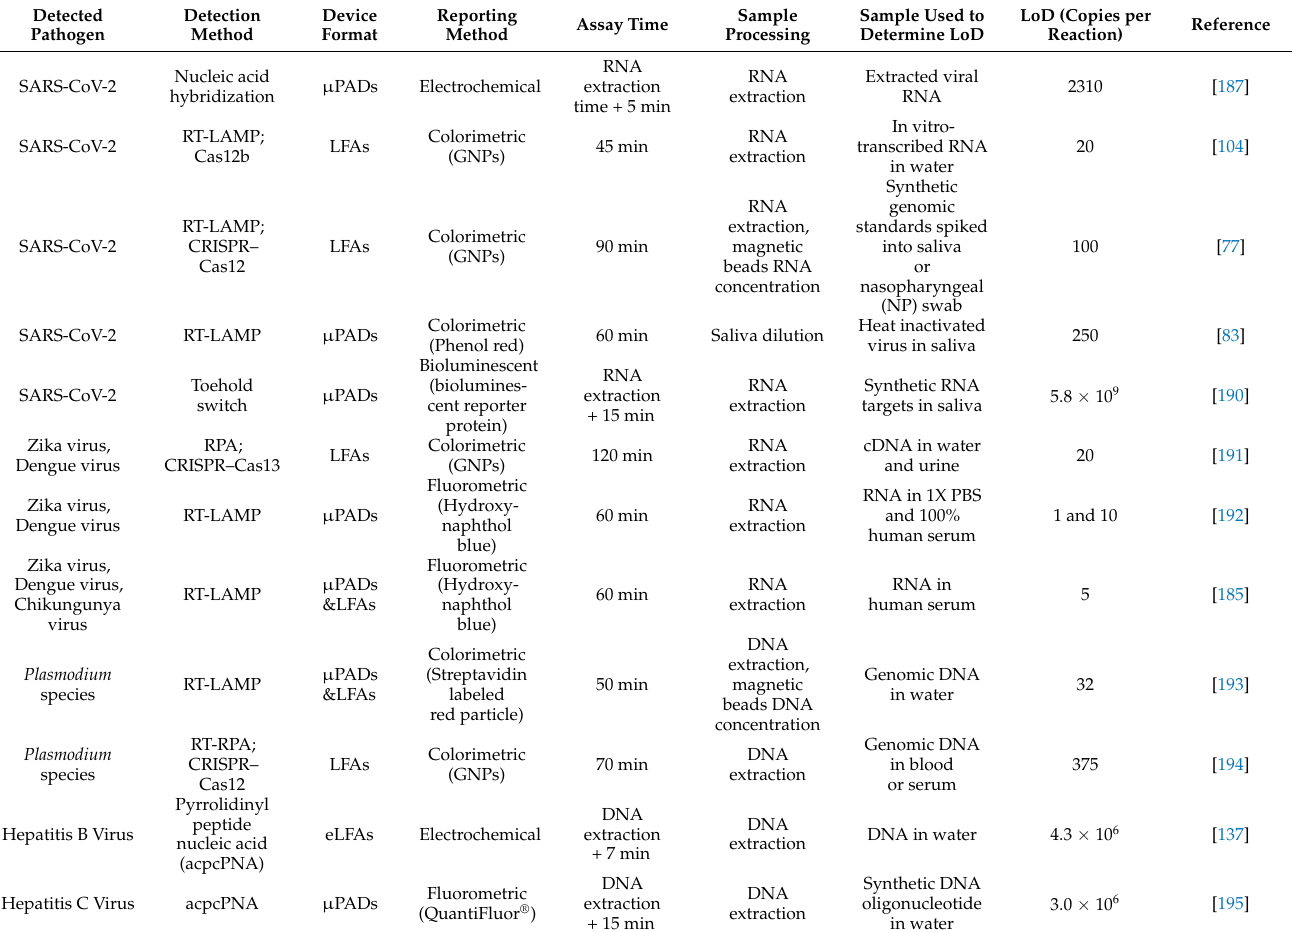
Table 3. Summary of paper-based biosensors for the detection of nucleic